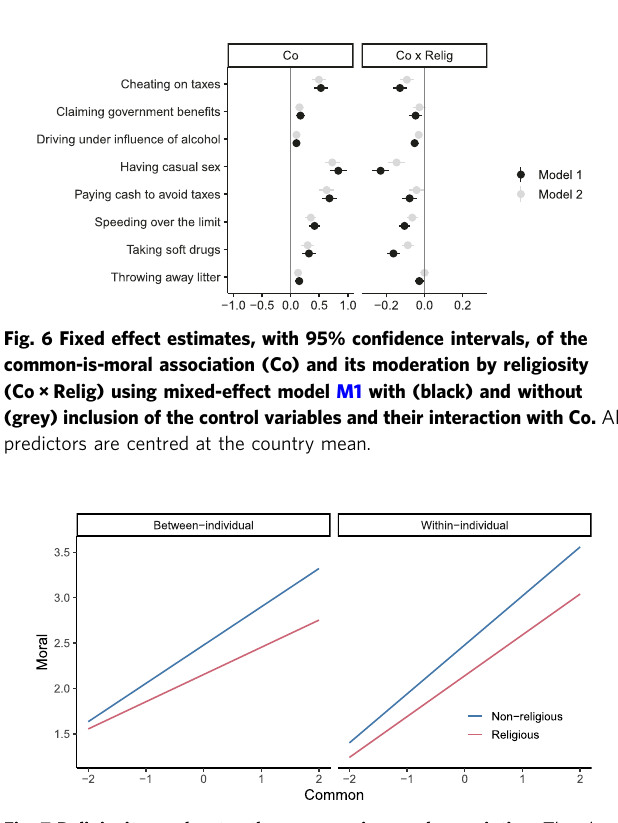
Fig. 7 Religiosity moderates the common-is-moral association. The slope of the blue line represents the estimated common-is-moral association for an average behaviour in the average country among non-religious individuals (1 scale unit lower than the average). The red line has less slope, representing the estimated common-is-moral association for an average behaviour in the average country among religious individuals (1 scale unit above the average).